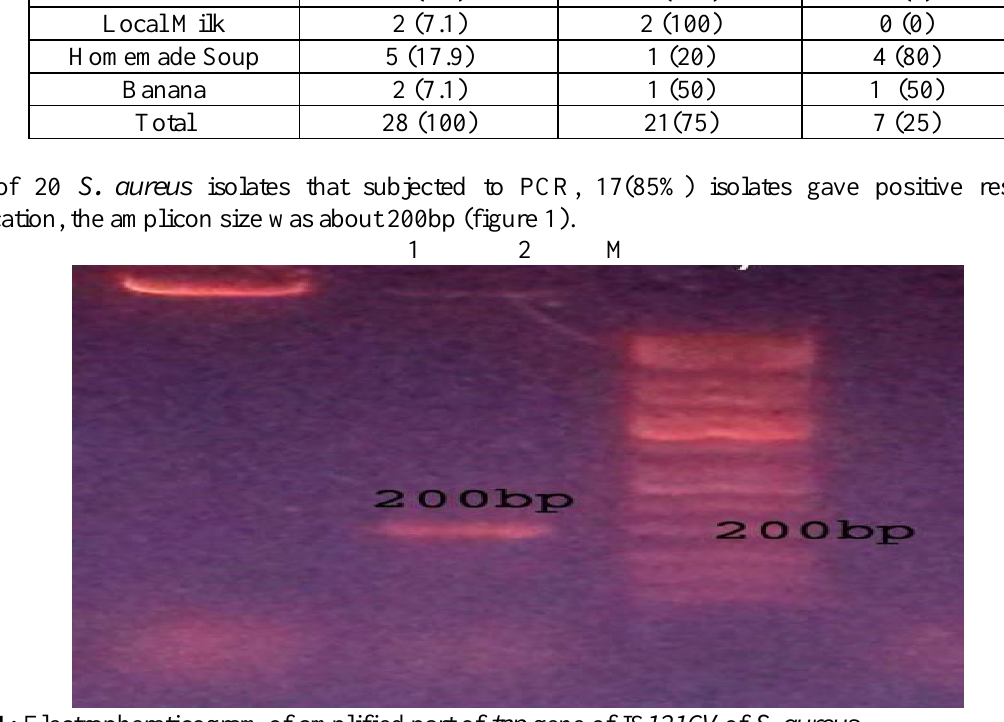
Figure 1: Electrophereticogram of amplified part of tnp gene of IS 1216V of S. aureus . M:100bp ladder, 1,2 lanes are negative and positive results respectively. The electrophoresis was done by 1.5% agarose gel at 7V/cm for 90